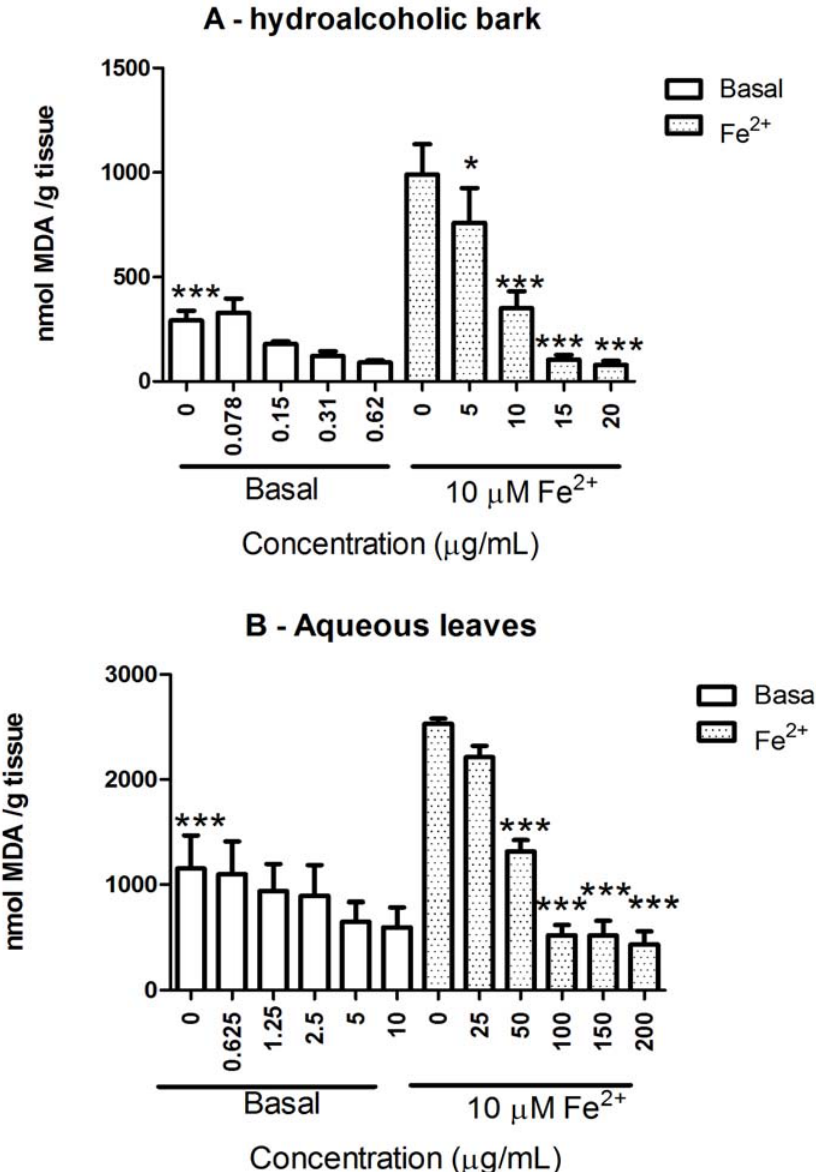
Figure 2. Antioxidant properties of different extracts from S. rotundifolium Mart.: ( A ): hydroalcoholic bark extract; ( B ): aqueous leaves extract; ( C ): aqueous bark extract. Lipid peroxidation (TBARS production) in brain homogenates was determined either in the absence or in the presence of Fe 2+ (10 µM). Values are expressed as mean ± SEM from 3 to 4 independent experiments performed in duplicate. *** p < 0.001 vs . Fe 2+ -induced TBARS; * p < 0.05 vs . Fe 2+ -induced TBARS; *** p < 0.001 vs .